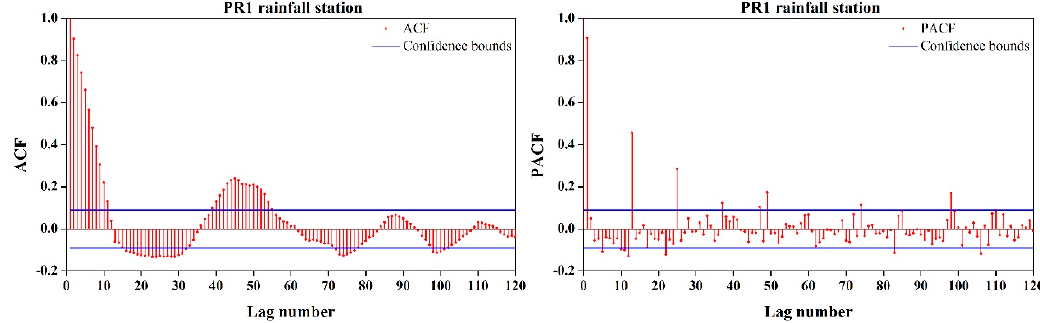
Figure 2. Autocorrelation function (ACF) and partial autocorrelation function (PACF) plots for model selection at the PR1 station in the Pozi River basin.